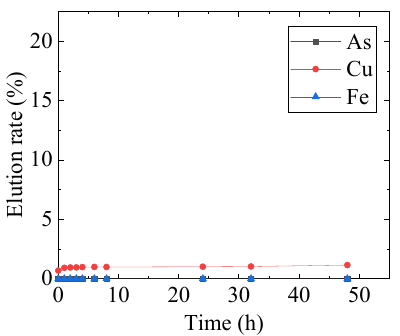
Figure 1. Elution rate of As, Cu and Fe from original (as-prepared) samples in water.